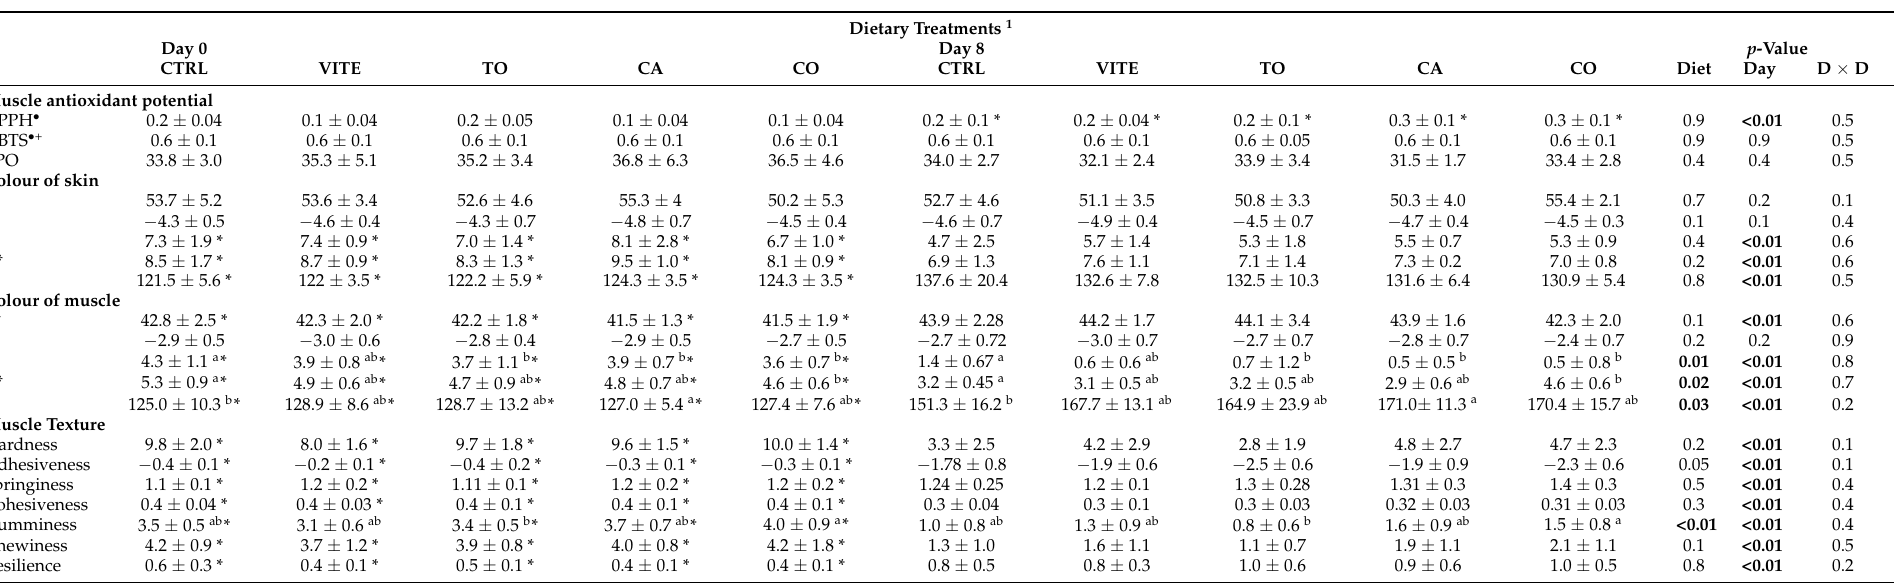
Table 7. Antioxidant potential, skin and muscle colour and texture of Dicentrarchus labrax in the first sampling day (Day 0) and after 8 days of storage (Day